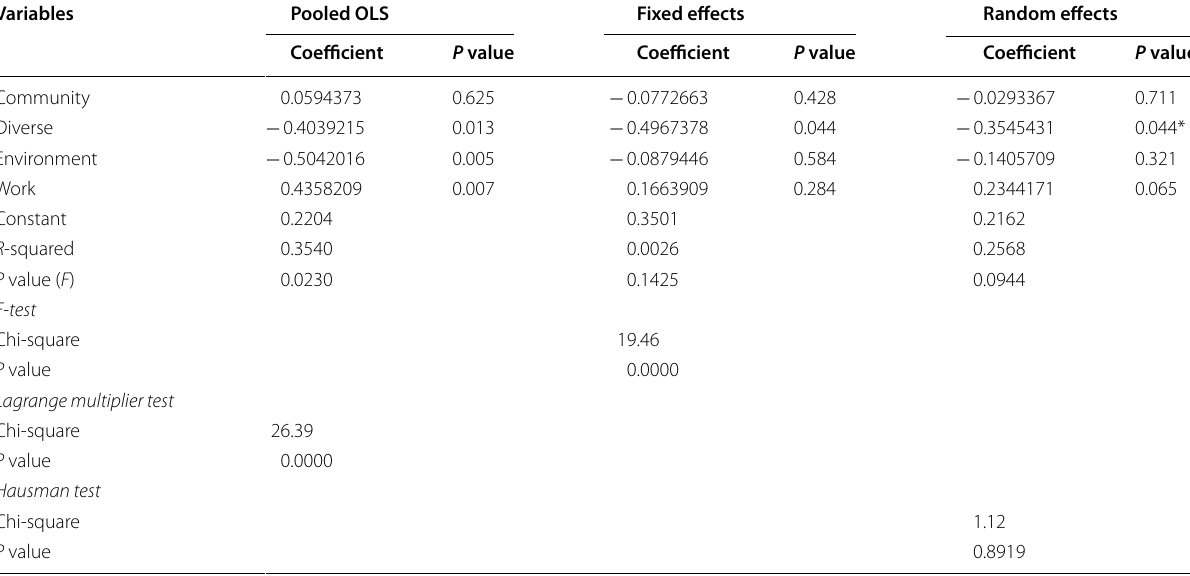
The result is evaluated based on a 95% level of significance